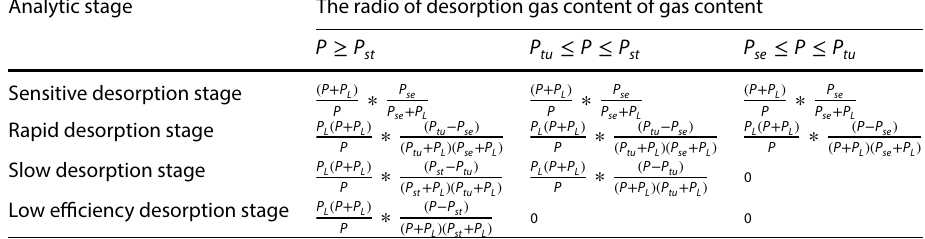
Table 1 the ratio of desorption gas content of gas content in different stages of shale interpretation under different reservoir pressure conditions